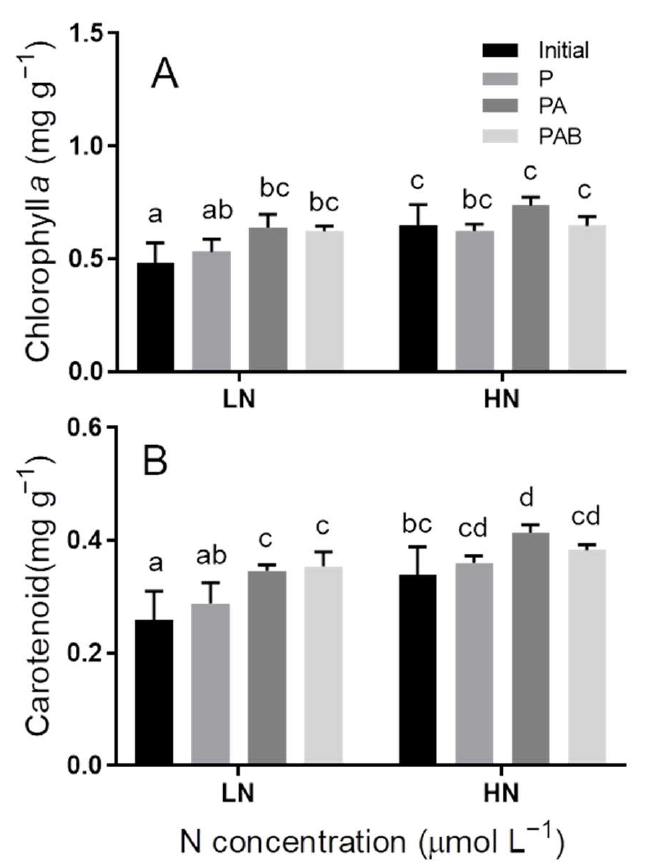
Figure 8. Chlorophyll a ( A ) and carotenoids ( B ) of Sargassum horneri under P, PA, and PAB treatments. Significant differences among all treatments are indicated by different lowercase letters ( p < 0.05).